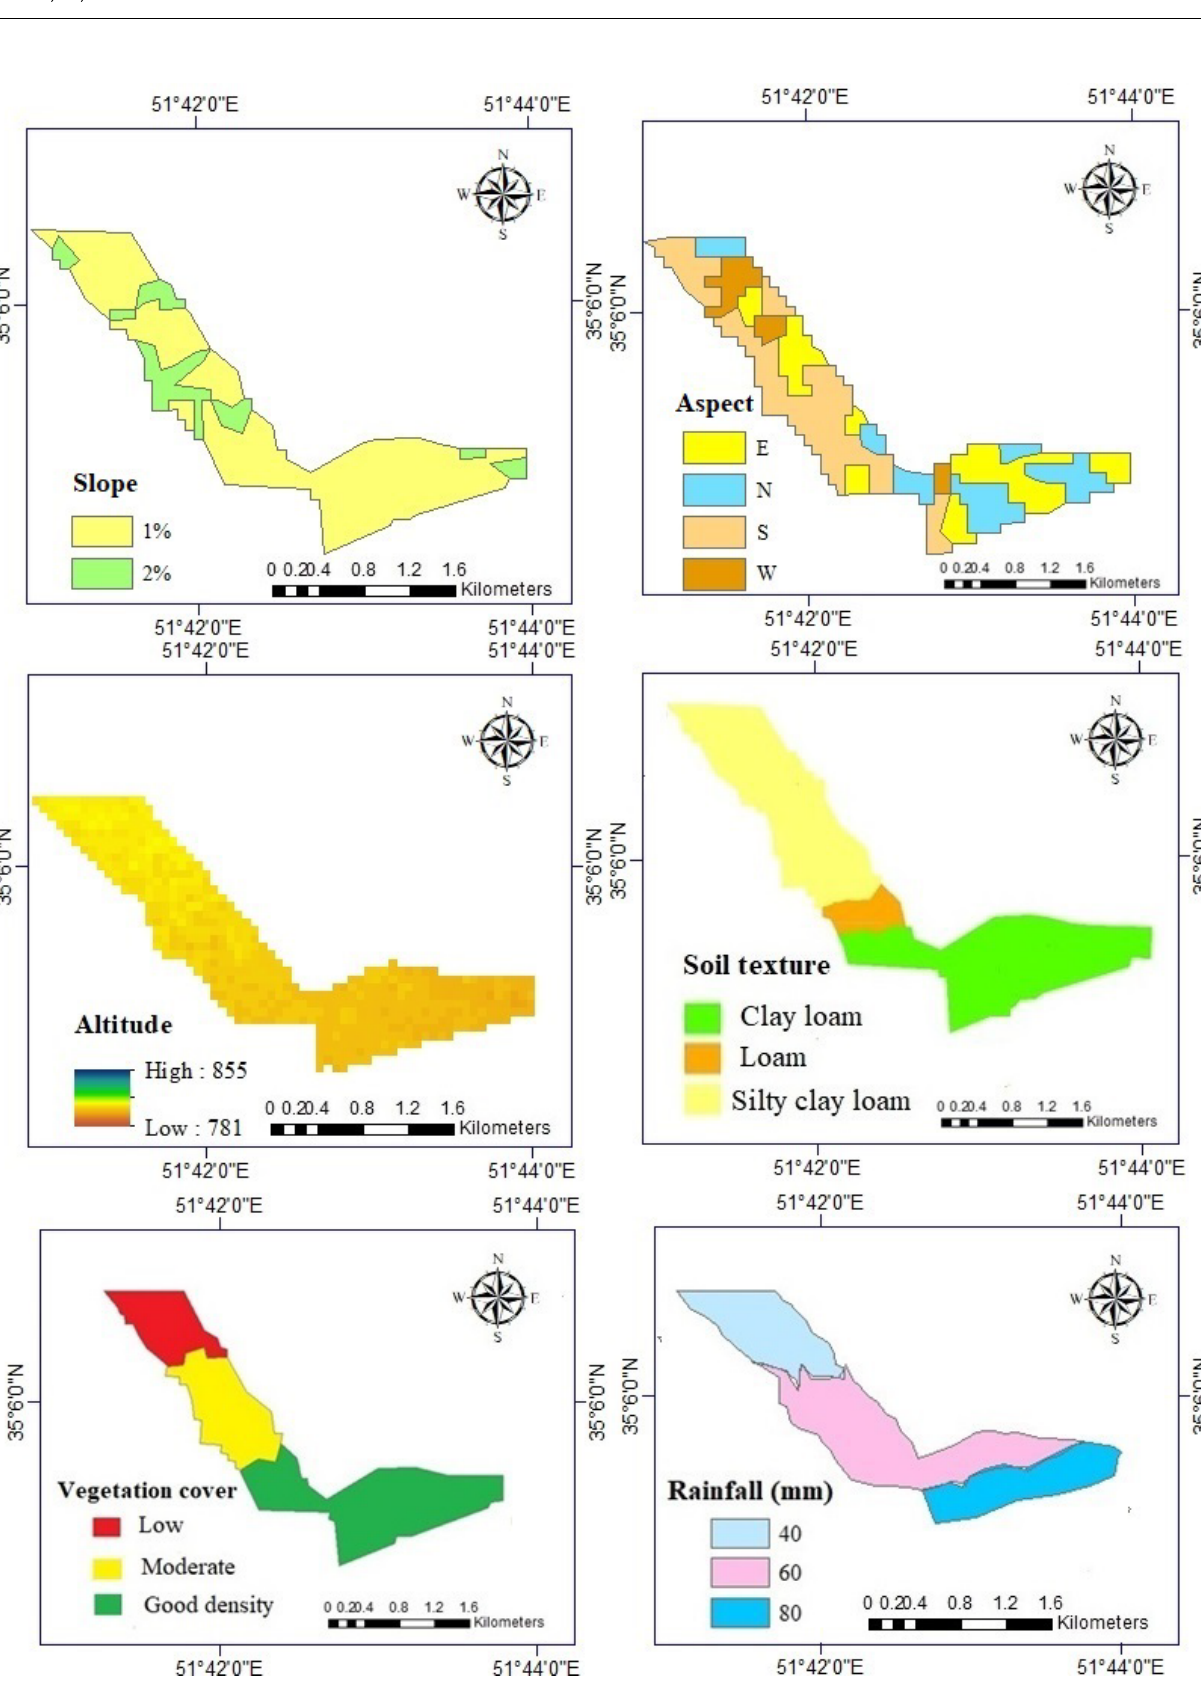
Figure 3. Classification map of ecological factors in Shokrabad region.